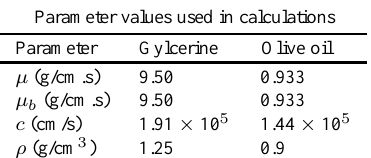
Table 1 Parameter values used in calculations Parameter Gylcerine Olive oil µ